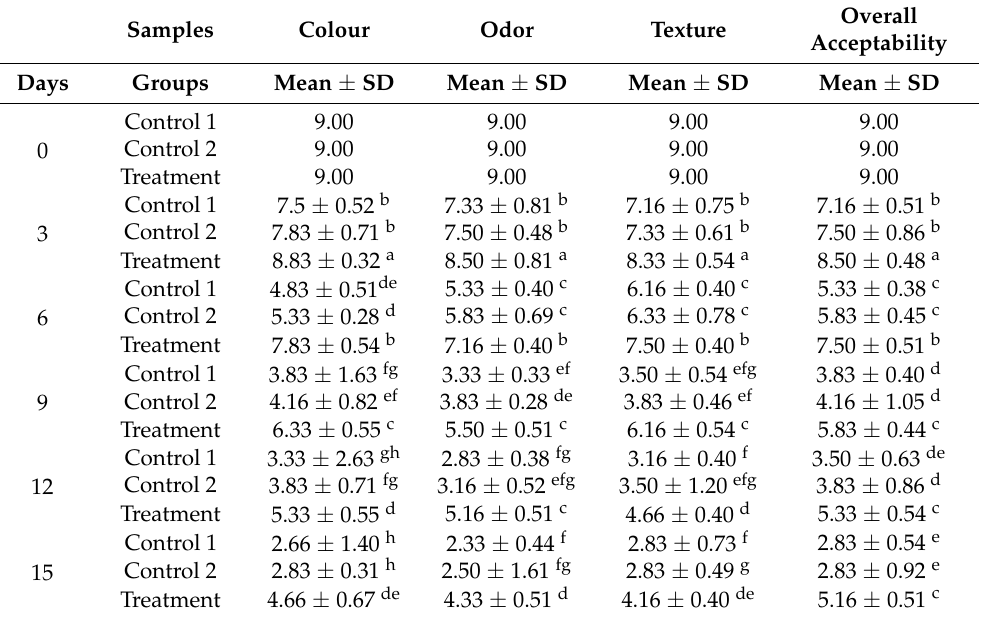
Table 6. The effect of active film containing MEO and CWE on the sensory properties of turkey breast meat stored at 4 ◦ C. Different lowercase letters were determined to be significant at p ≤